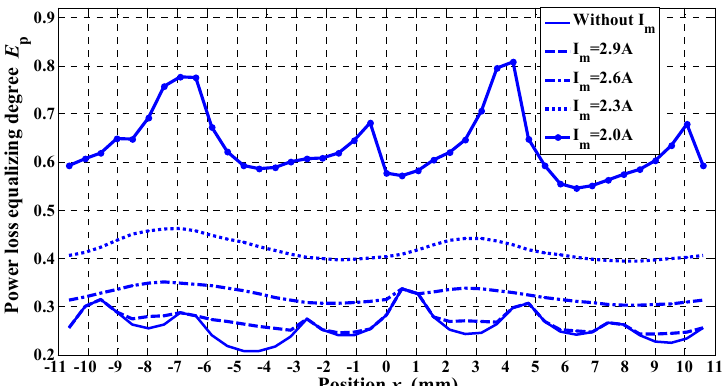
Figure 8. Power loss equalizing degree when the commutations are optimized without boundary constraint I m , with boundary constraint I m = 2.9 A, 2.6 A, 2.3 A, and 2.0 A, respectively.